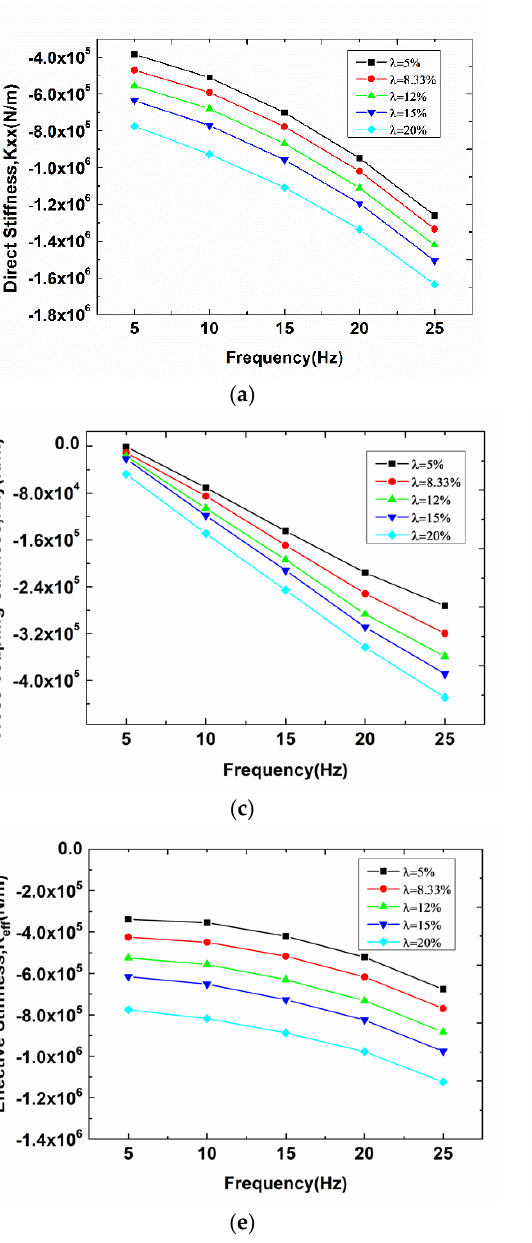
Figure 12. Direct stiffness K xx ( a ), direct damping C xx ( b ), cross-coupling stiffness K xy ( c ), cross- coupling damping C xy ( d ), effective stiffness K eff ( e ) and effective damping C eff ( f ) of the annular seal in Case 2 (impeller blades number m = 5).